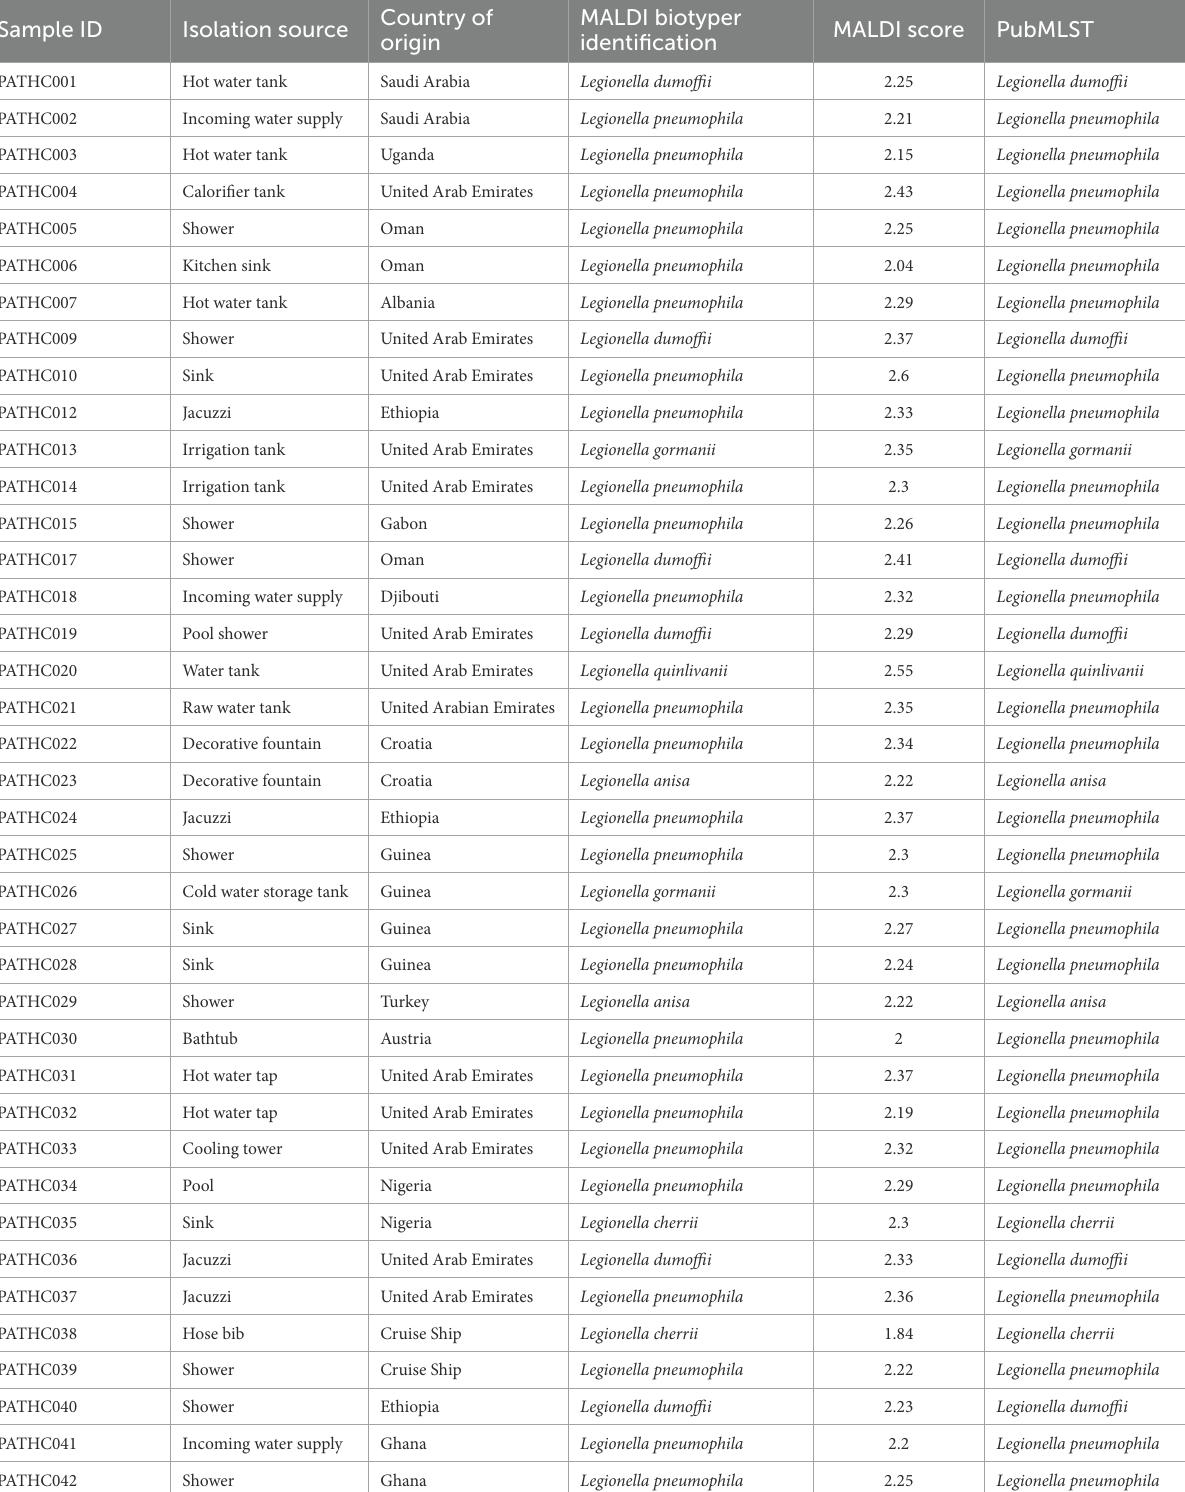
TABLE 1 Isolates selected for the study along with their country of origin, isolation source, results of MALDI-TOF typing, and PubMLST